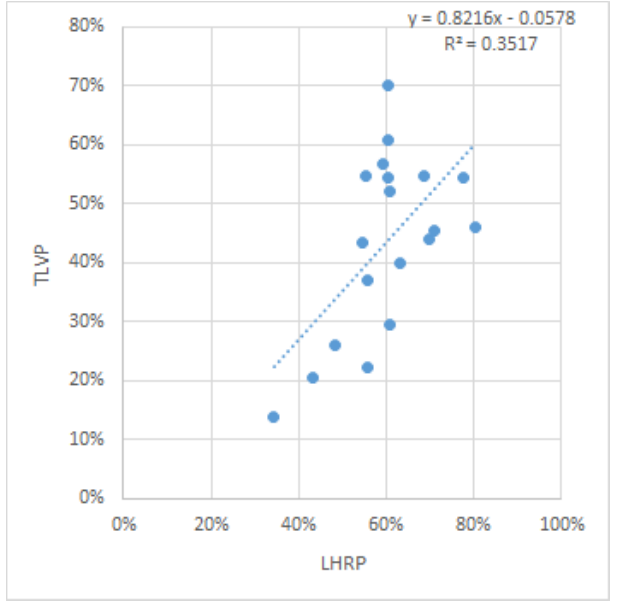
Figure 6. Correlation graphic showing the correlation between the LHRP and TLVP after removal of the three most extreme